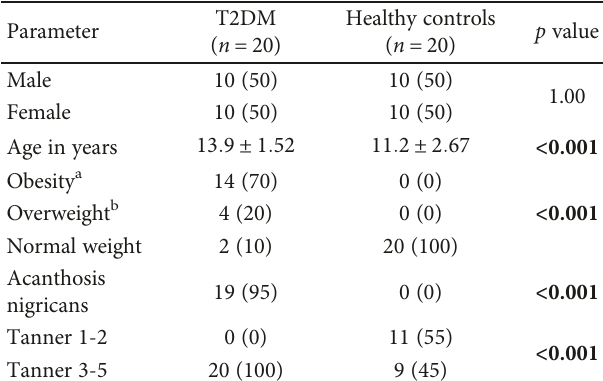
Table 1: Demographic and clinical characteristics of the